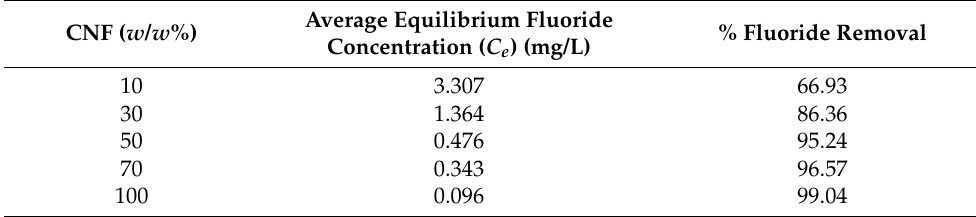
Table 1. Optimization of CNF % weight in the CNF-AgMgOnHaP adsorbent for F −